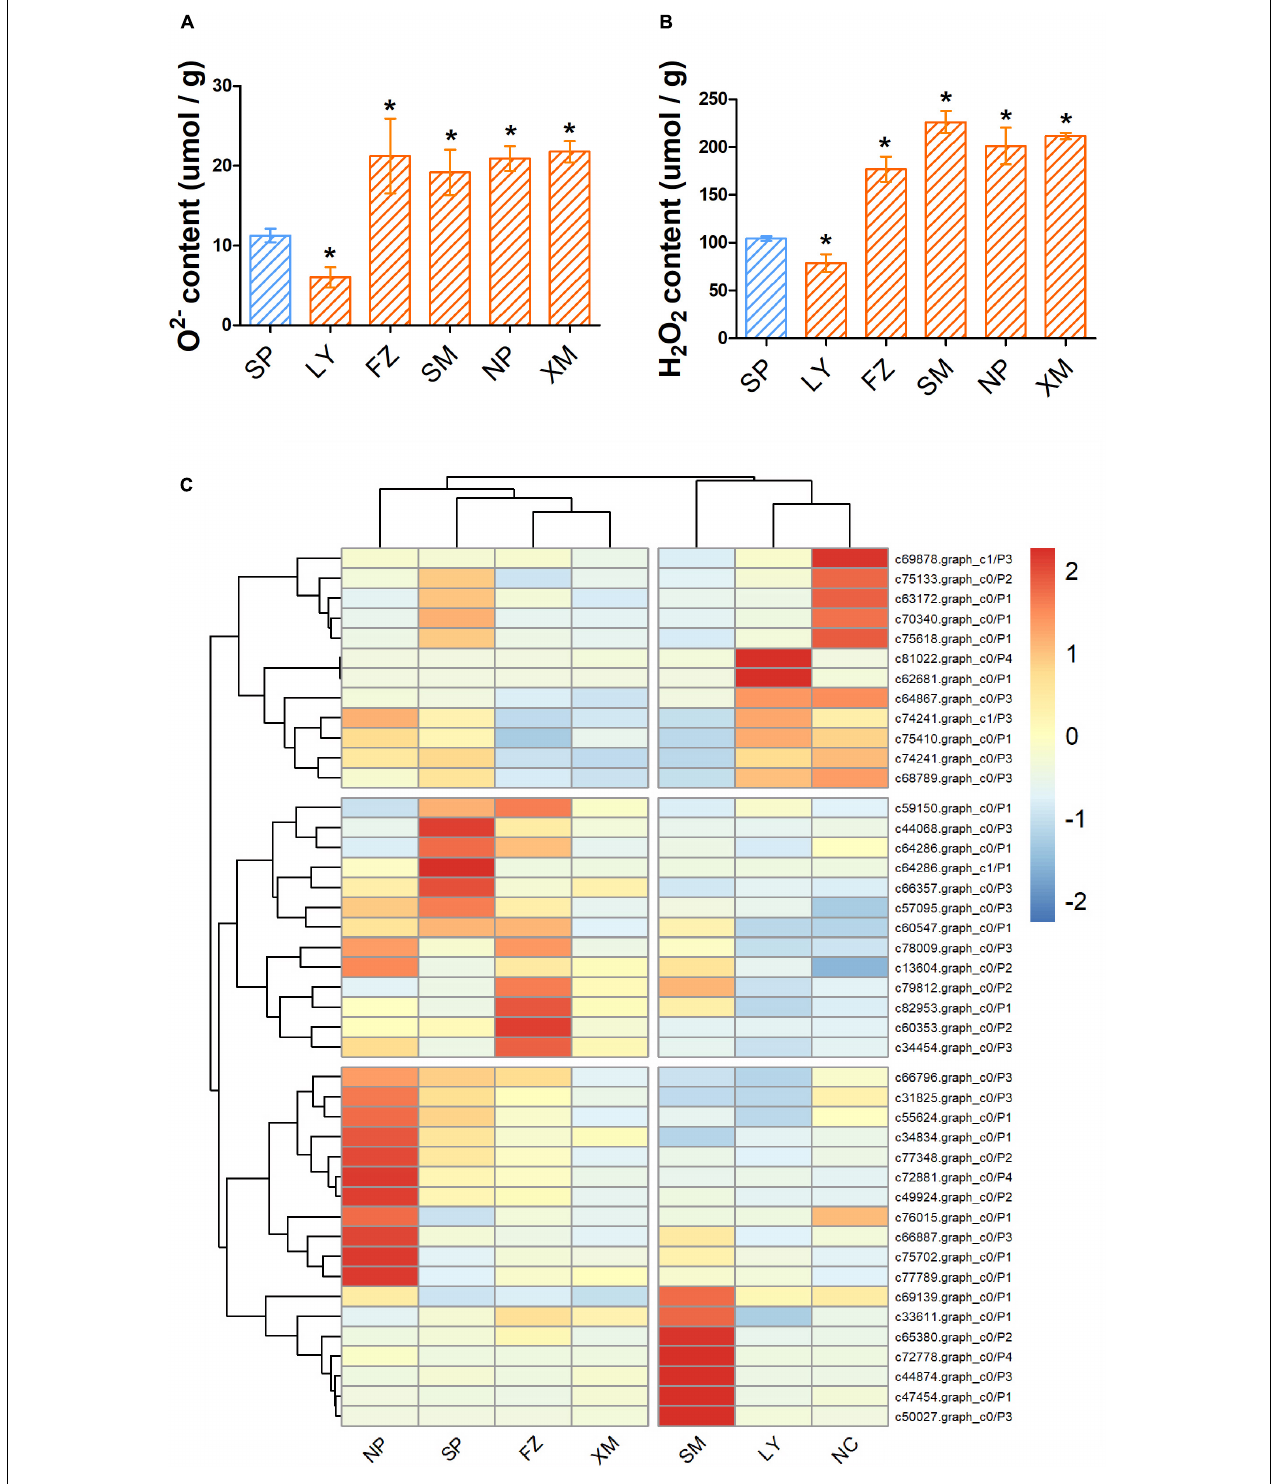
FIGURE 4 | ROS content and the expression of PWN resistance genes in inoculated seedlings. Masson pine seedlings were harvested 14 days after inoculation with different APMSs (LY, FZ, SM, NP, and XM); sterilized PWN (SP) were used as a control. O 2 − (A) and H 2 O 2 (B) content in different samples are represented as mean ± SD. (C) Cluster analysis of expression of unigenes encoding stress responsive pathways (P1), ROS scavenging pathways (P2), terpenoid biosynthesis pathways (P3), and syncytium formation (P4) among different samples, with non-infected seedlings as negative control (NC). “*” represents a significant difference compared with SP (Student’s test, p <